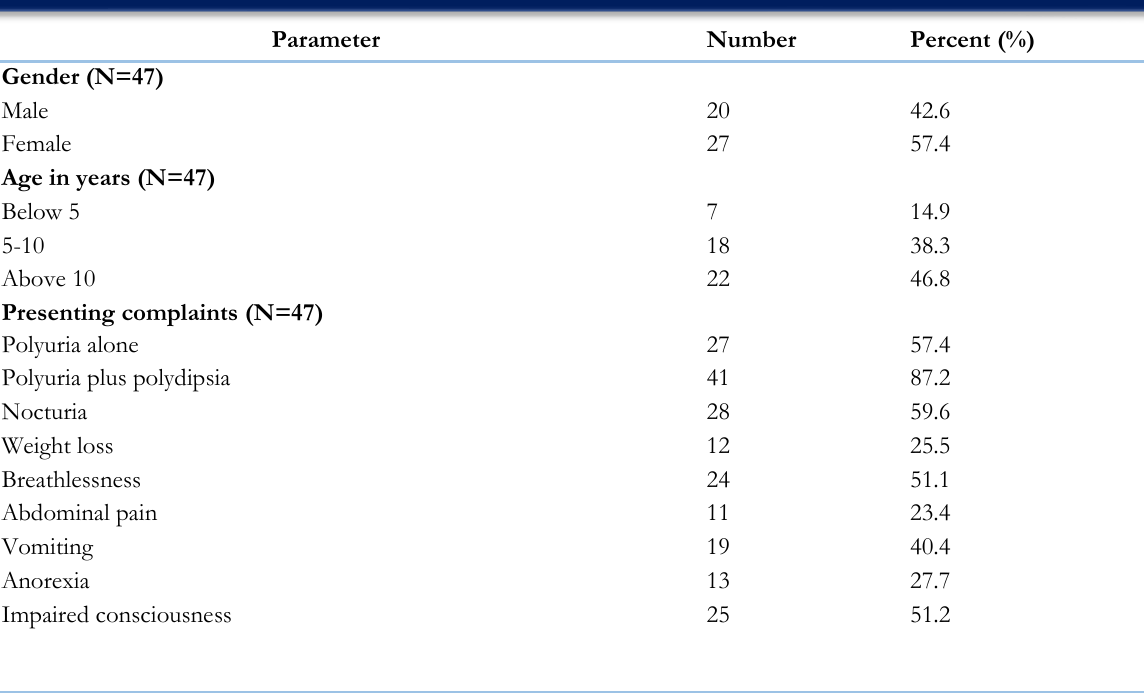
Table 1: Distribution of gender, age and presenting complaints among the subjects.